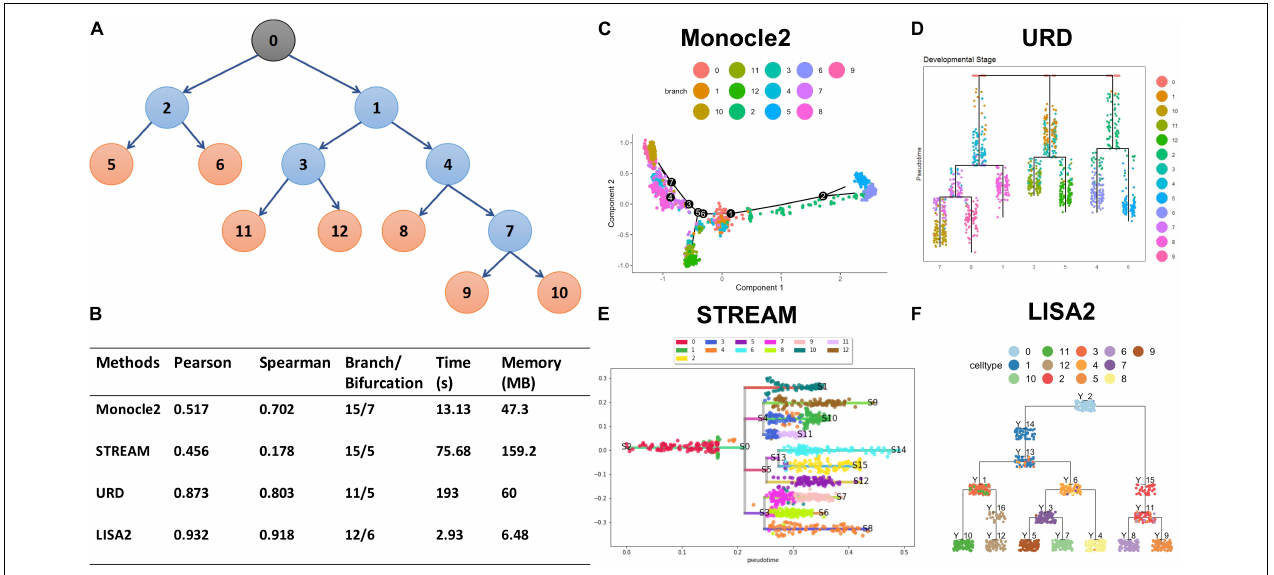
FIGURE 5 | Comparisons of LISA2 with other methods on simulation data. (A) The cartoon plot of the trajectory of simulation data with raw branches. The black 0 node is the root. The orange nodes are the leaf branches. The blue nodes are the middle branches. (B) Comparisons of the trajectories from four methods on pseudotime, branch, running time, and memory usage. (C) The Monocle 2 trajectory for the simulation data (top 20 PCs used). (D) The URD trajectory for the simulation data (38 cells not visited). (E) The STREAM trajectory for the simulation data (all genes were used). (F) The LISA2 trajectory for the simulation